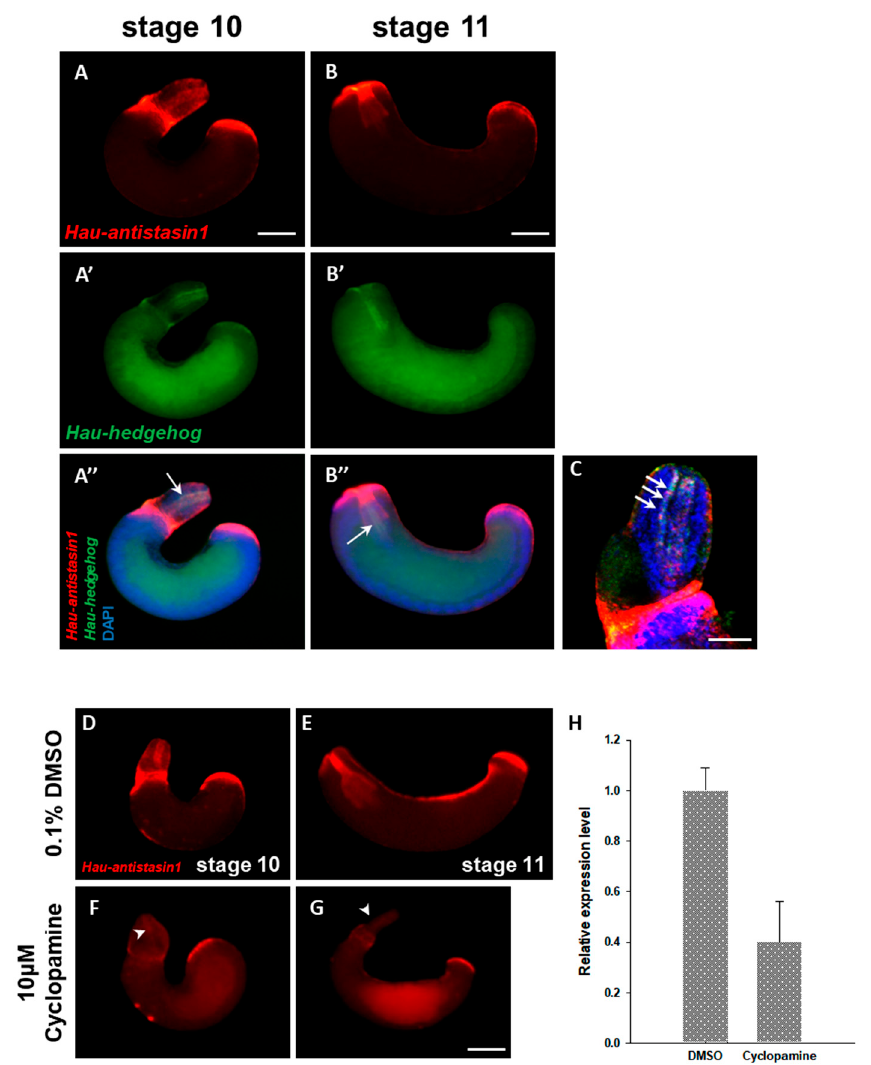
Figure 5. Co-localization of Hau-hedgehog (hh) and Hau-antistasin1 , and cyclopamine treatment test. ( A , A’ , A” , B , B’ , B” ) Hau-antistasin1 is expressed in the proboscis cavity during organogenesis. To confirm the overlapping expression region with hh , we carried out the double fluorescent in situ hybridization (DFISH). In the proboscis cavity, hh expression overlaps with Hau-antistasin1 . ( C ) High magnification view of overlapped expression pattern. Hau-antistasin1 and Hau-hh are co-localized in the proboscis cavity. ( D – G ) Treatment with 10 µ M cyclopamine leads to proboscis malformation and failure of proboscis invagination when compared with 0.1% DMSO. Hau-antistasin1 expression is decreased in the proboscis cavity (white arrowhead). ( H ) Quantitative mRNA expression of Hau-antistasin1 . Result is shown as mean ± standard deviation. Scale bar: A–B”, D–G = 200 µ m; C = 50 µ